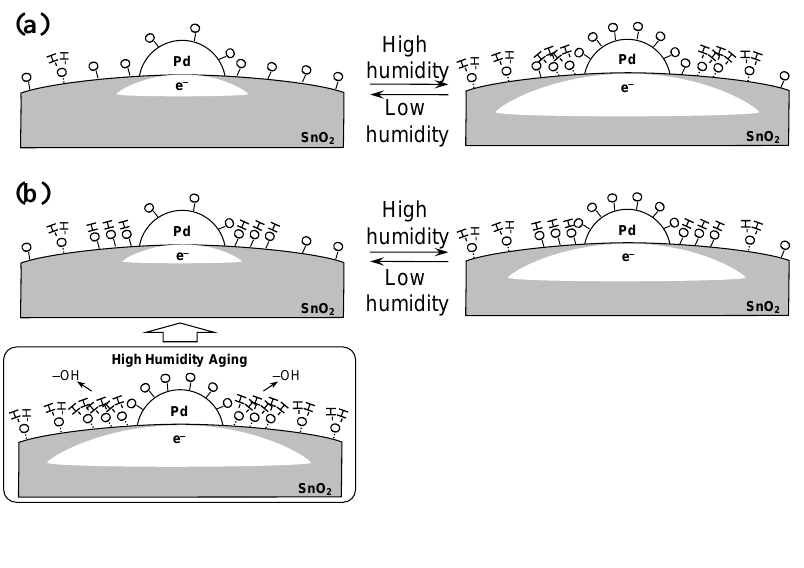
Figure. 4. Depictions of the surface conditions of Pd-loading area on (a) the non-aged Pt,Pd,Au/SnO and (b) the high-humidity aging treated Pt,Pd,Au/SnO 2